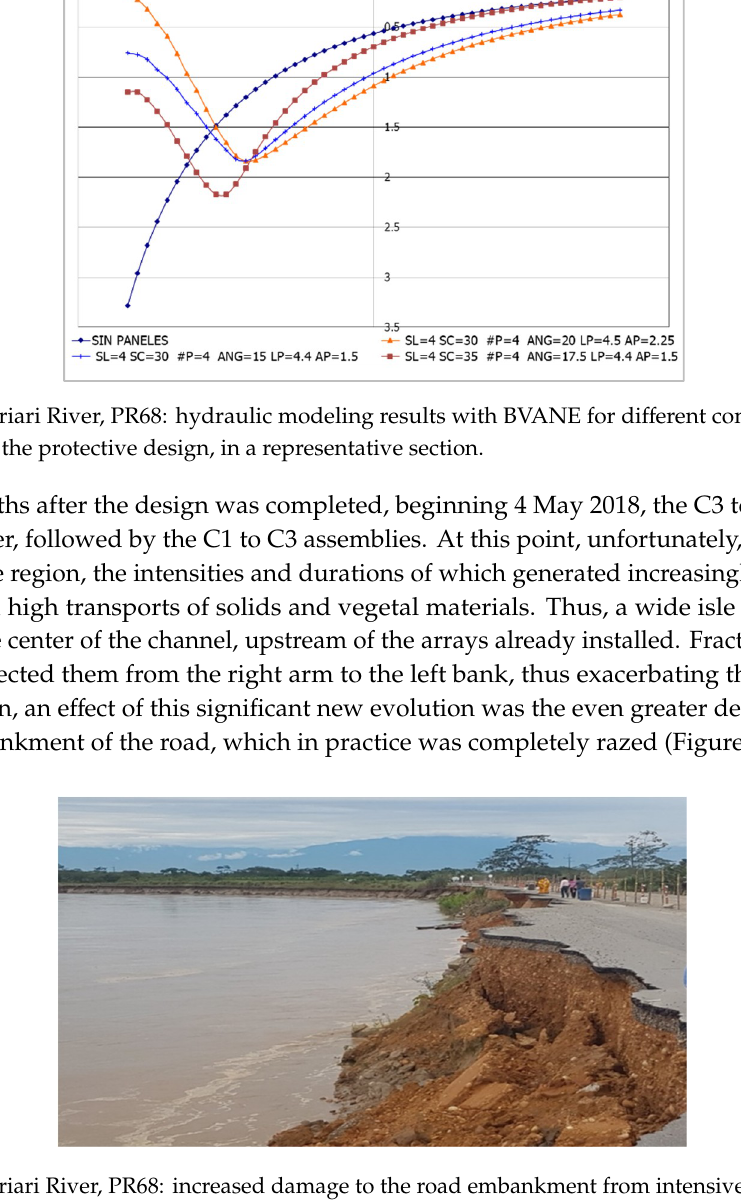
May and June 2018 (Source: Hidroconsulta).